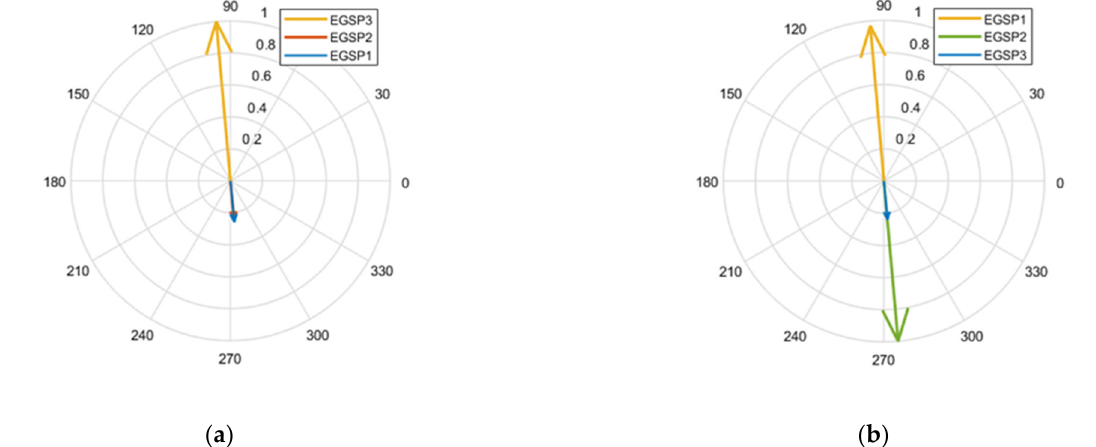
Figure 13. High Import DP: ( a ) oscillation vector of mode M3; ( b ) oscillation vector of mode M4. Mode M5 has a frequency of 1.66 Hz and a damping factor of 9.91%. The oscillation vector is shown in Figure 14a. This mode is a local mode in which the 22.8 MVA generator in Dittaino (DITP) and the 58.1 MVA generator in Augusta (ESSP2), both not equipped with PSS, oscillate against the larger generator located in Priolo Gargallo, PRGP1, with a rated power of 370 MVA, a large constant of inertia of 7.5 s and equipped with PSS. For this reason, the magnitude of the oscillation vector of PRGP1 effectively appears like a dot in the origin.